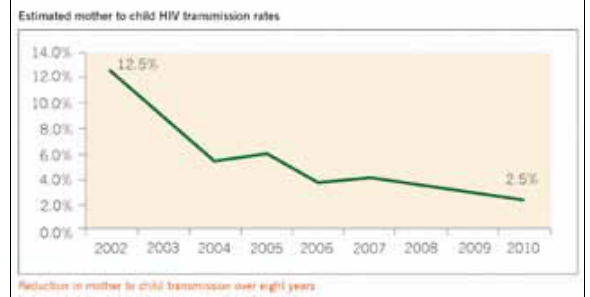
Fig. 2. Khayelitsha antenatal prevalence, 1999 - 2010.CHC = community health centre; City Clinic = City of Cape Town